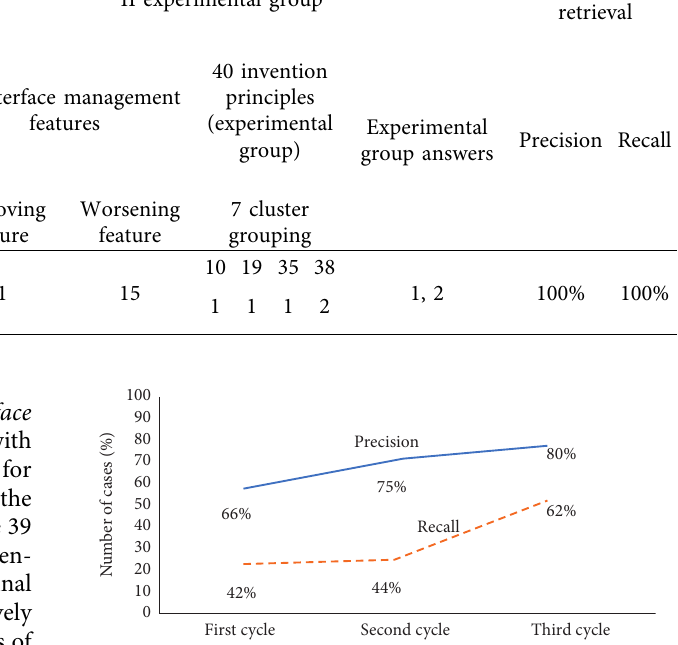
Figure 4: System optimization and enhancement